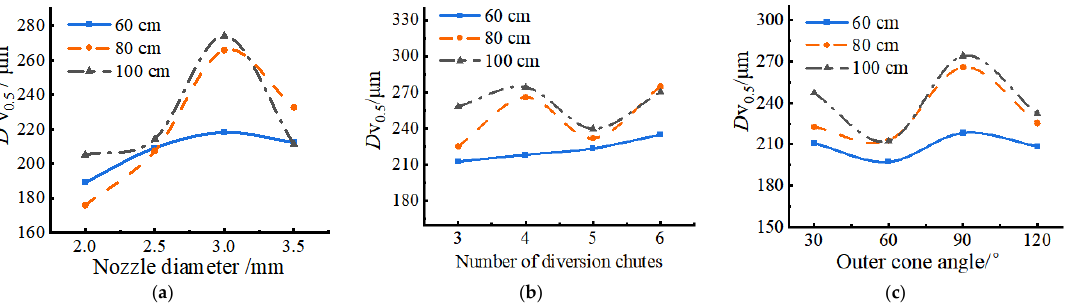
Figure 7. The influence of key structures on droplet size. ( a ) Nozzle diameter; ( b ) number of diversion chutes; ( c ) outer cone angle.